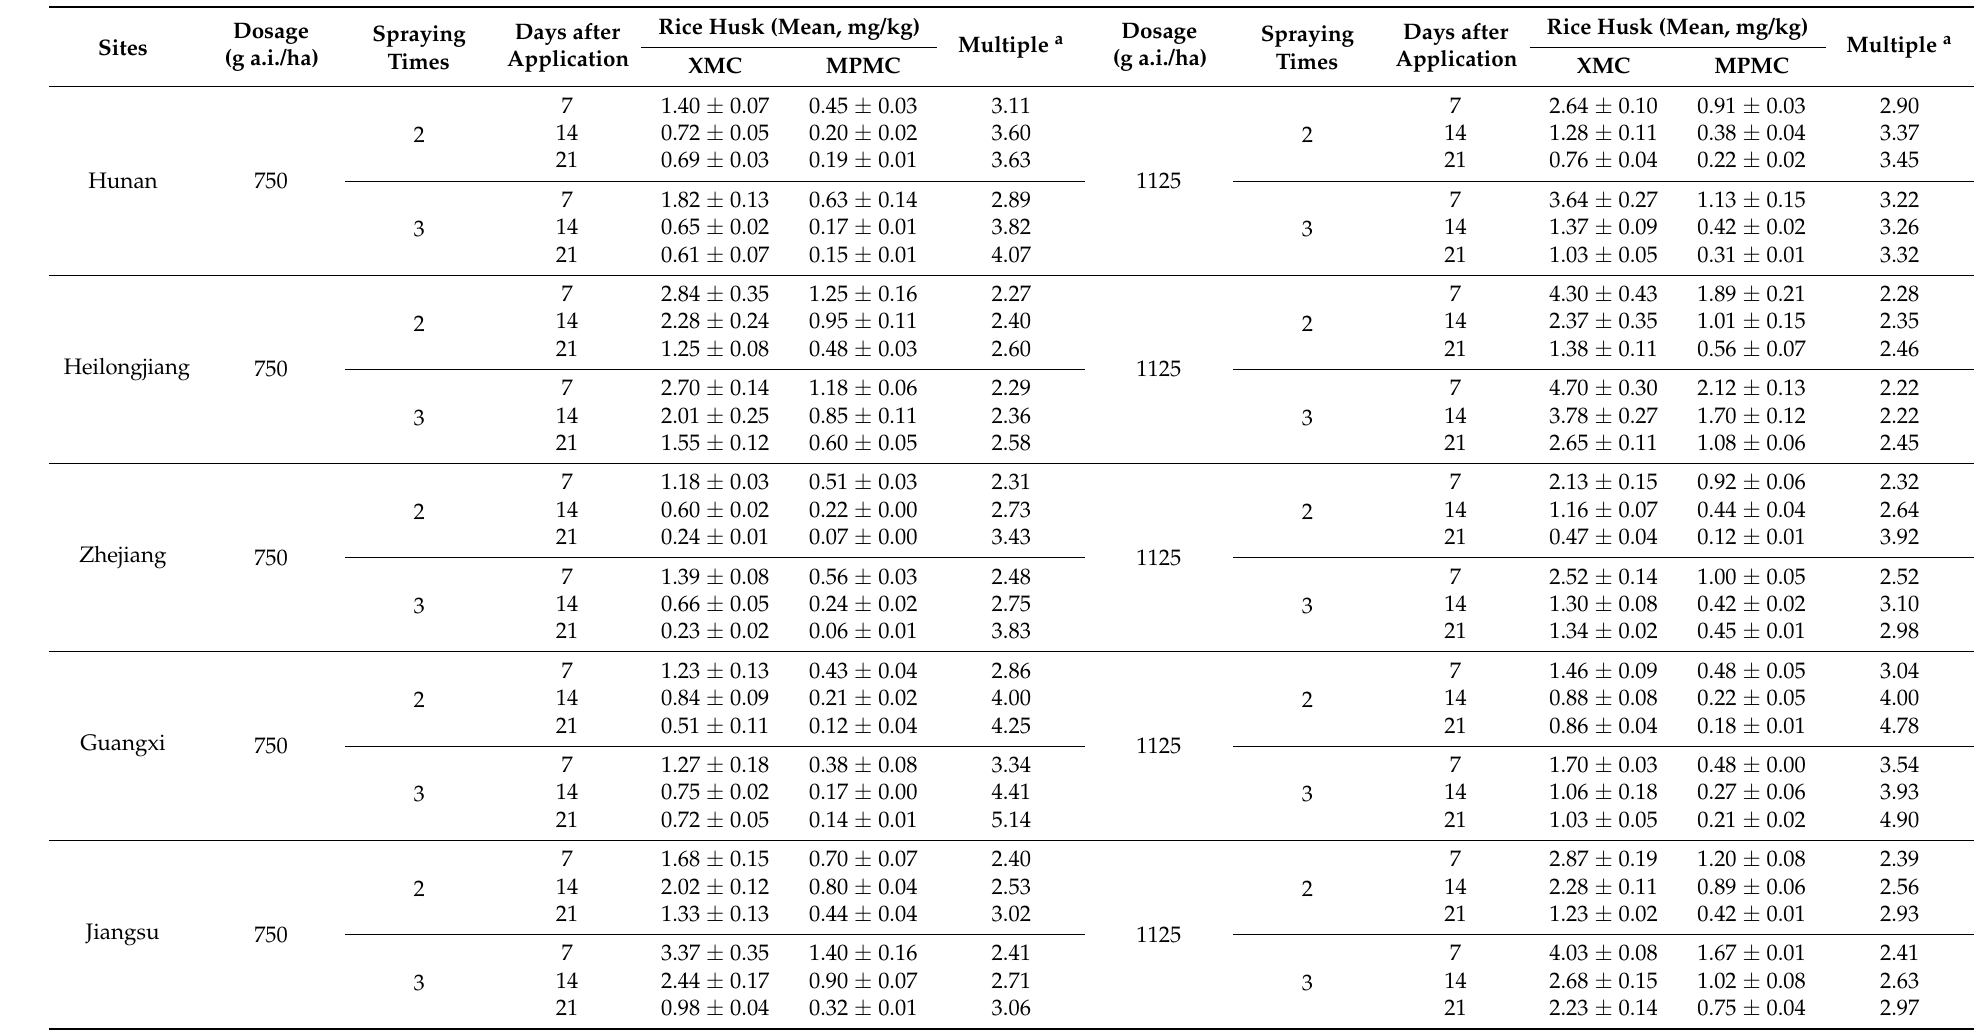
Table 3. Field-incurred residues of dimethacarb in rice